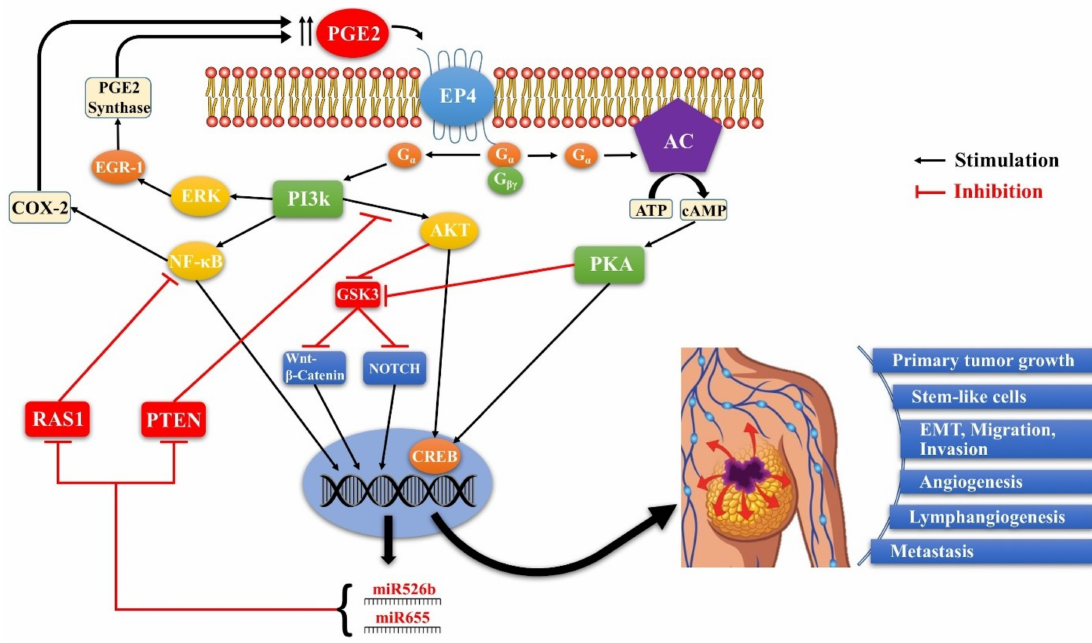
Figure 8. Schema of EP4 mediated signaling pathways in COX-2 expressing breast cancer. Aberrant COX- 2 activity leads to tumor progression and metastasis by utilizing multiple signaling pathways in which EP4 activation plays a pivotal role, and two COX-2/EP4 upregulated miRNAs (miR526b activation leading to phosphorylation of the transcription factor CREB. PKA also upregulates